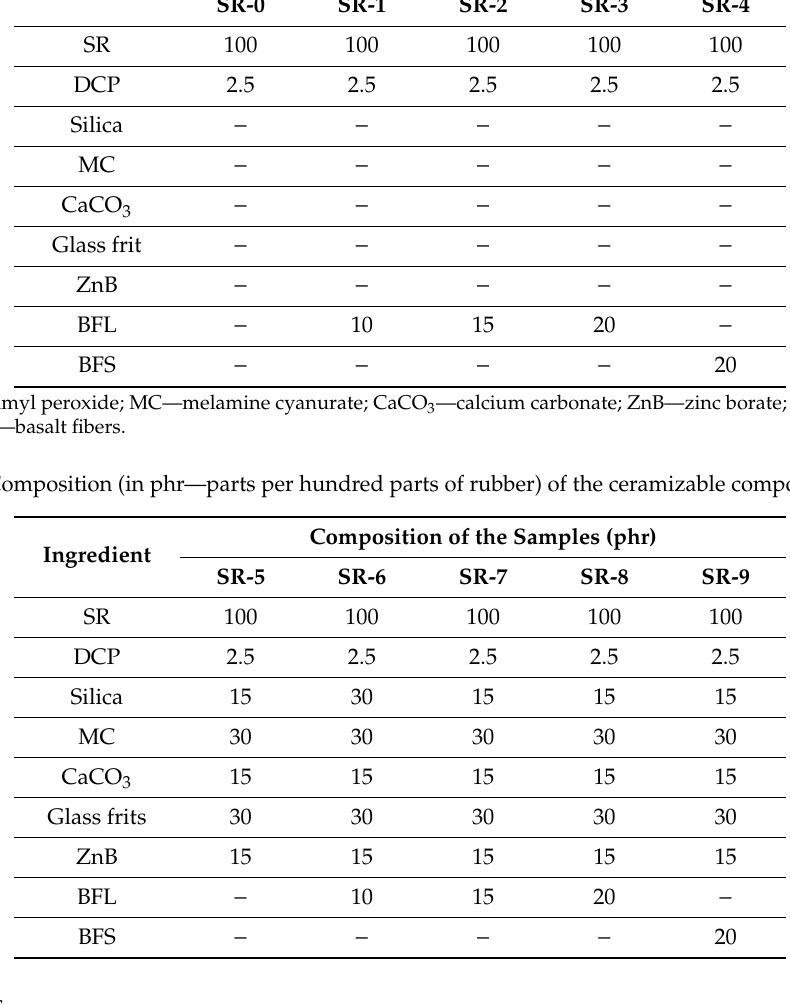
Table 1. Composition (in phr—parts per hundred parts of rubber) of the composite mixes. Composition of the Samples (phr) Ingredient SR-0